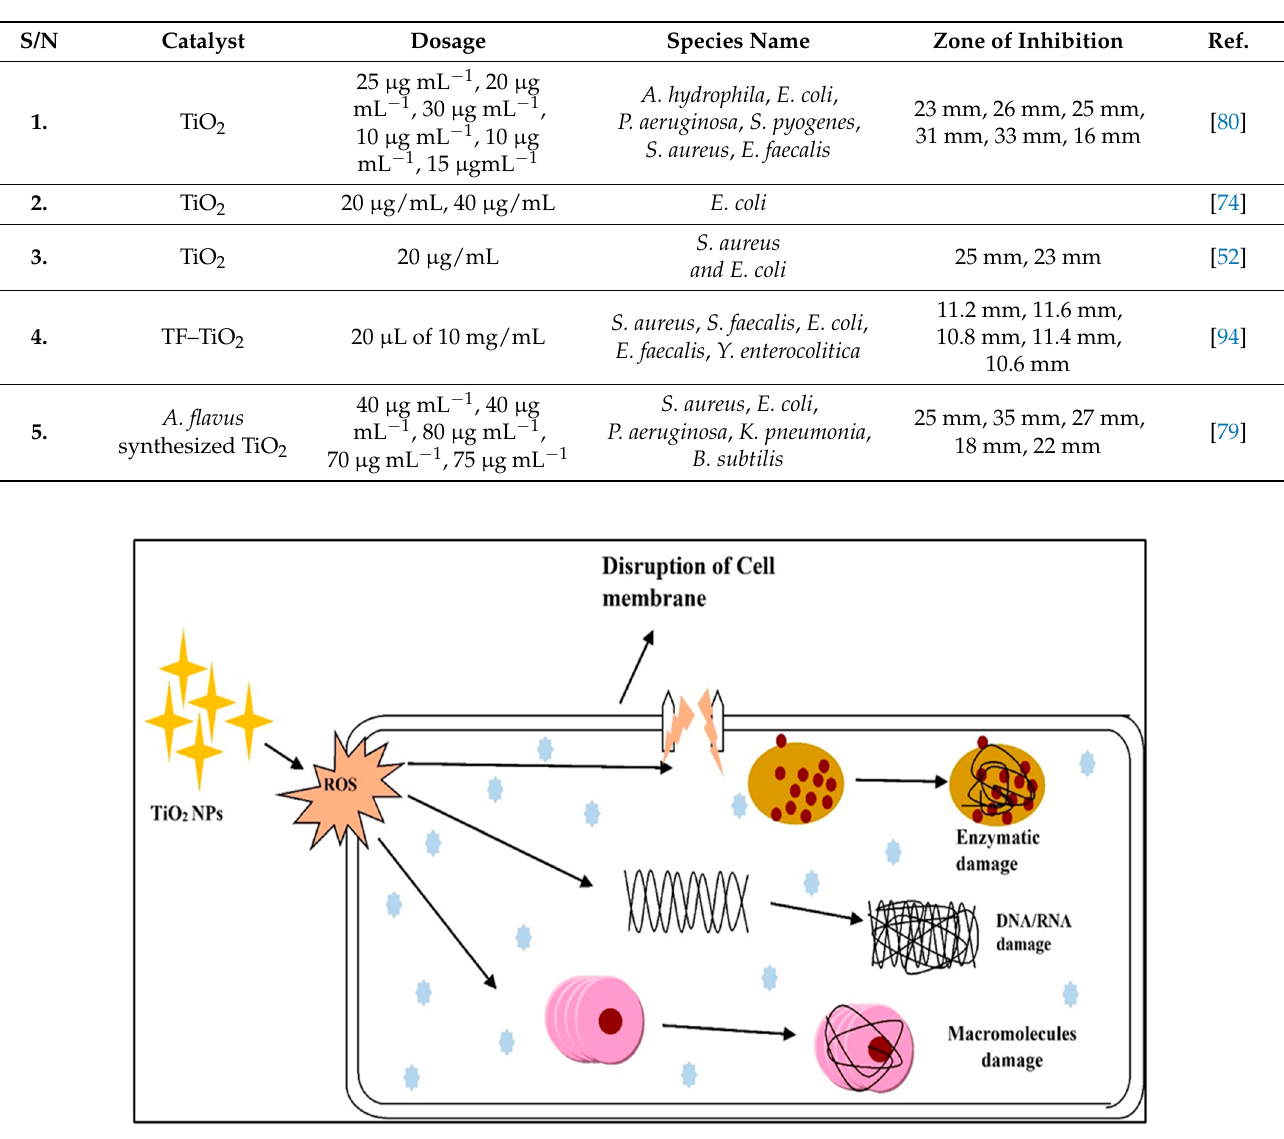
Table 4. Antimicrobial effect of Titanium dioxide NPs using different bacteria.